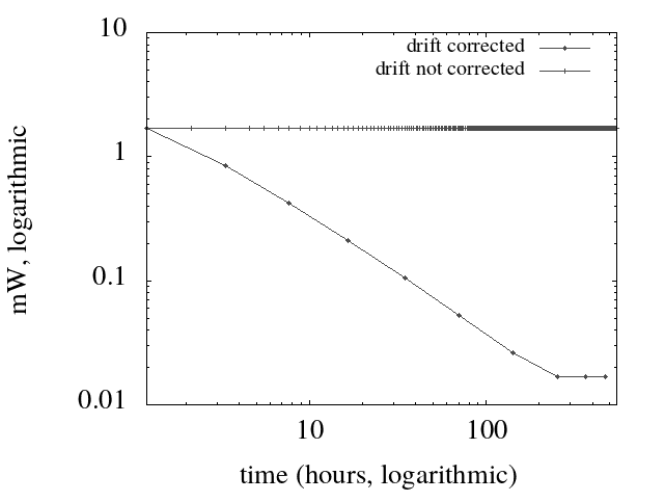
Figure 1. Comparison of the theoretical trend of power consumption during each period of the synchronization process, with and without drift correction. Each mark corresponds to a synchronization event. Operational parameters are in Table 1. If drift is corrected (lower line), power consumption drops exponentially since the interval between synchronization events grows exponentially. The decreasing trend stops when the threshold drift uncertainty is reached. If drift is not corrected power consumption remains constant.